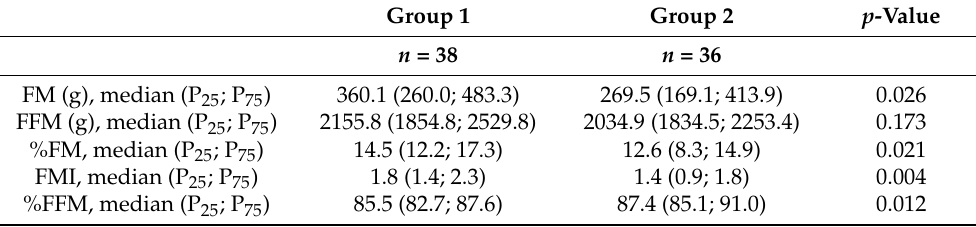
Table 5. Single assessment of body composition after discharge, between 35–41 weeks postmenstrual age ( n = 74). Group 1—fortified HM based on its assumed macronutrient content. Group 2—fortified HM based on its measured macronutrient